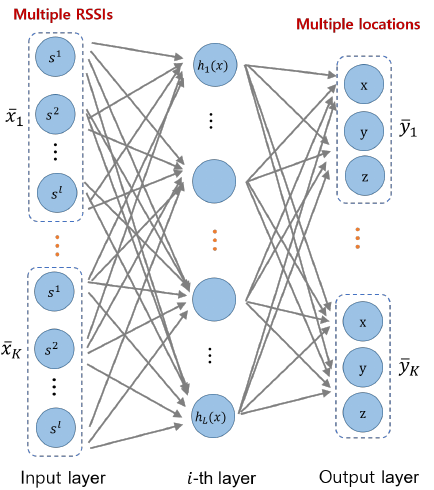
Figure 2. Deep neural network structure for single-position learning.